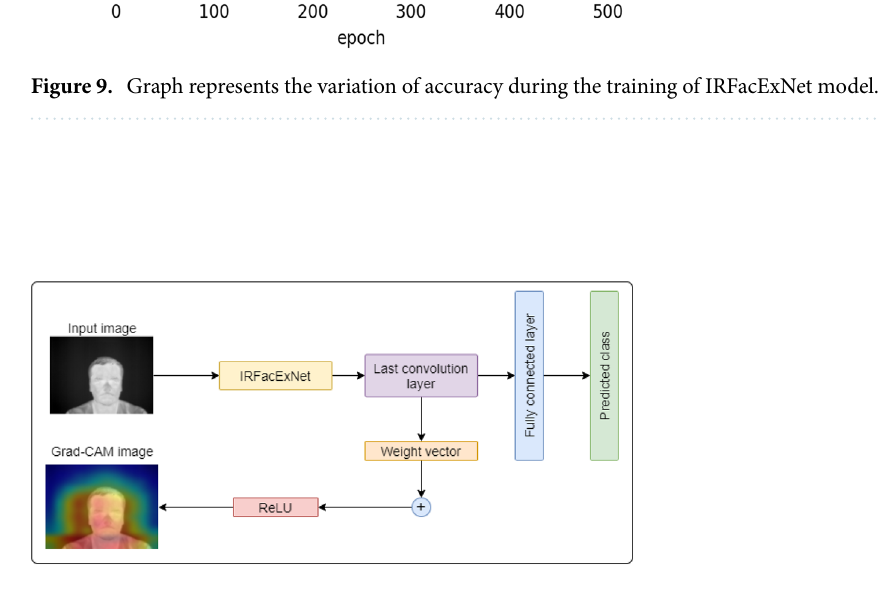
Figure 10. Outcome of the Grad-CAM analysis on an IR image for the proposed model—IRFacExNet. Image is developed using Draw.io 32